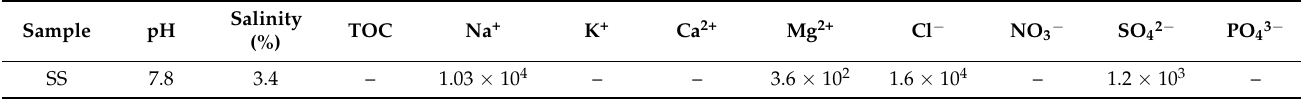
Table 3. Quality index of simulated seawater (mg L −1 ).